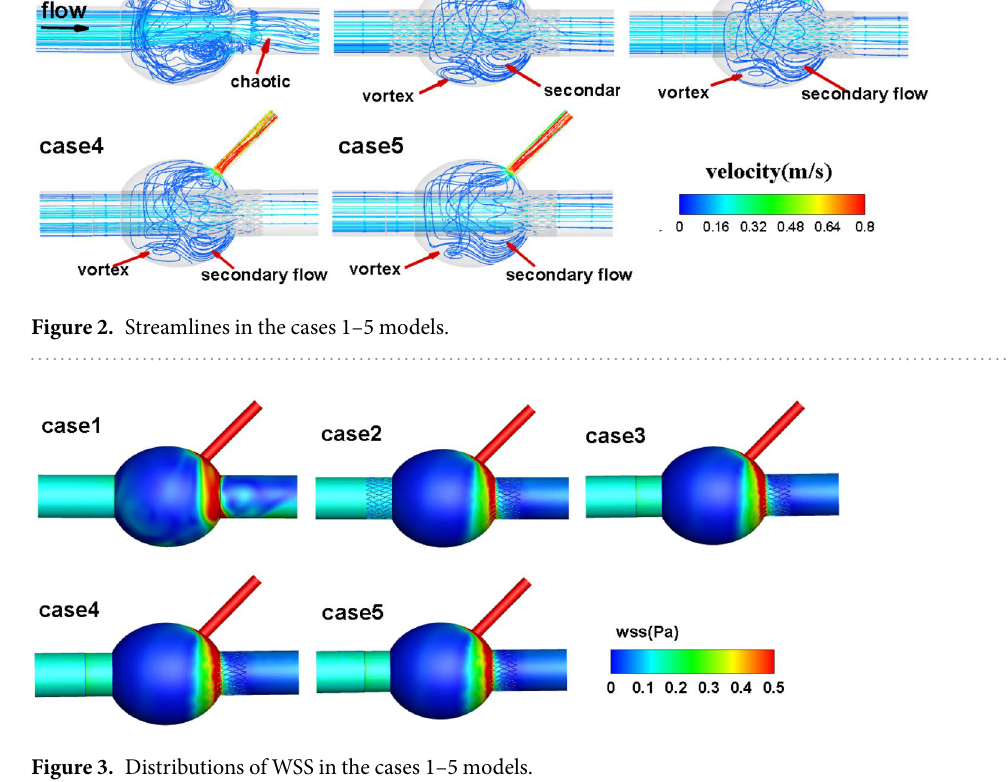
Figure 3. Distributions of WSS in the cases 1–5